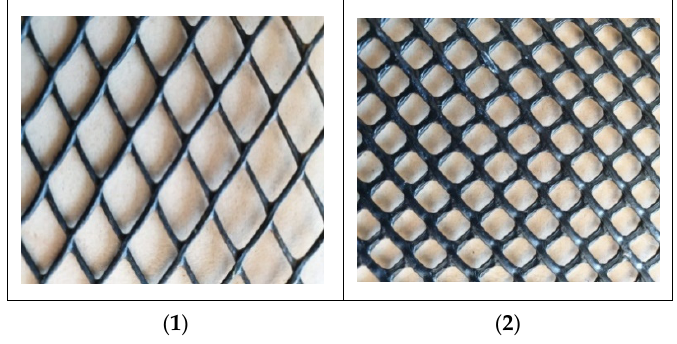
Figure 12. Non-woven plastic spacers ( 1 ) thin spacer, ( 2 ) thick spacer.